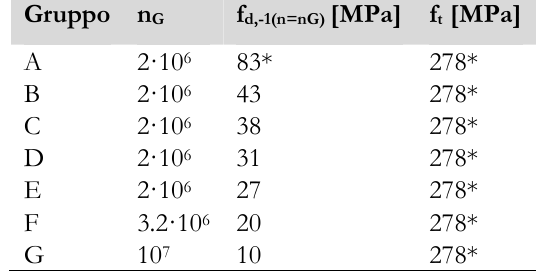
Figura 3: Curva di resistenza a fatica per giunti saldati in lega d’alluminio secondo UNI 8634 [1]. Gruppo n